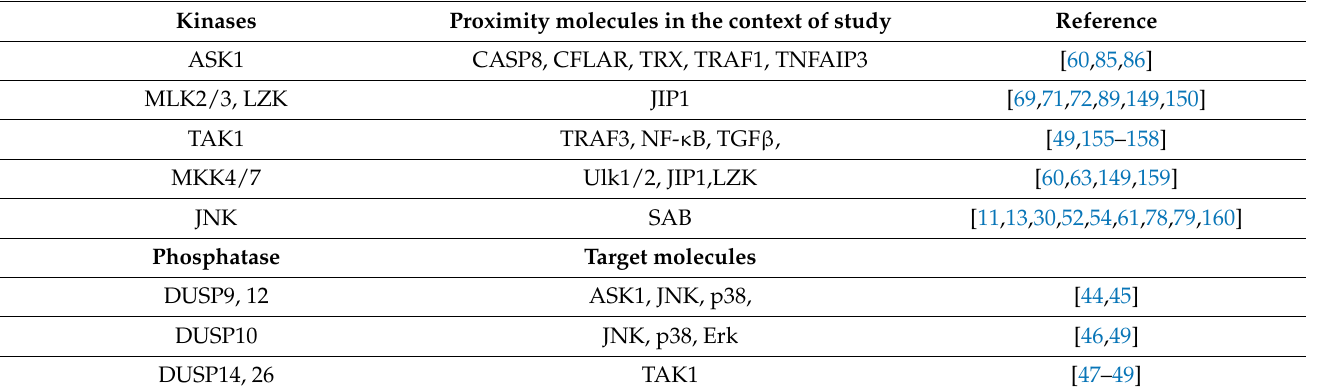
Table 1. Regulators of JNK activation in liver diseases. MAPKs, JNK and p38, are activated by upstream MAP kinase cascade which activity is dampened by interacting proteins or proteasomal degradation, or enhanced by membrane associated signal activation or reactive oxygen species (ROS). DUSP family phosphatases inhibition of MAP kinase cascade is critical in preventing susceptibility of hepatocyte toxicity and steatosis. Sustained activation of JNK via SAB-ROS-MAP3K overcomes the cellular protective mechanism and causes hepatocyte toxicity and lipogenesis. Regulators of JNK Activation in Hepatocyte Toxicity and Diet Induced NASH Kinases Proximity molecules in the context of